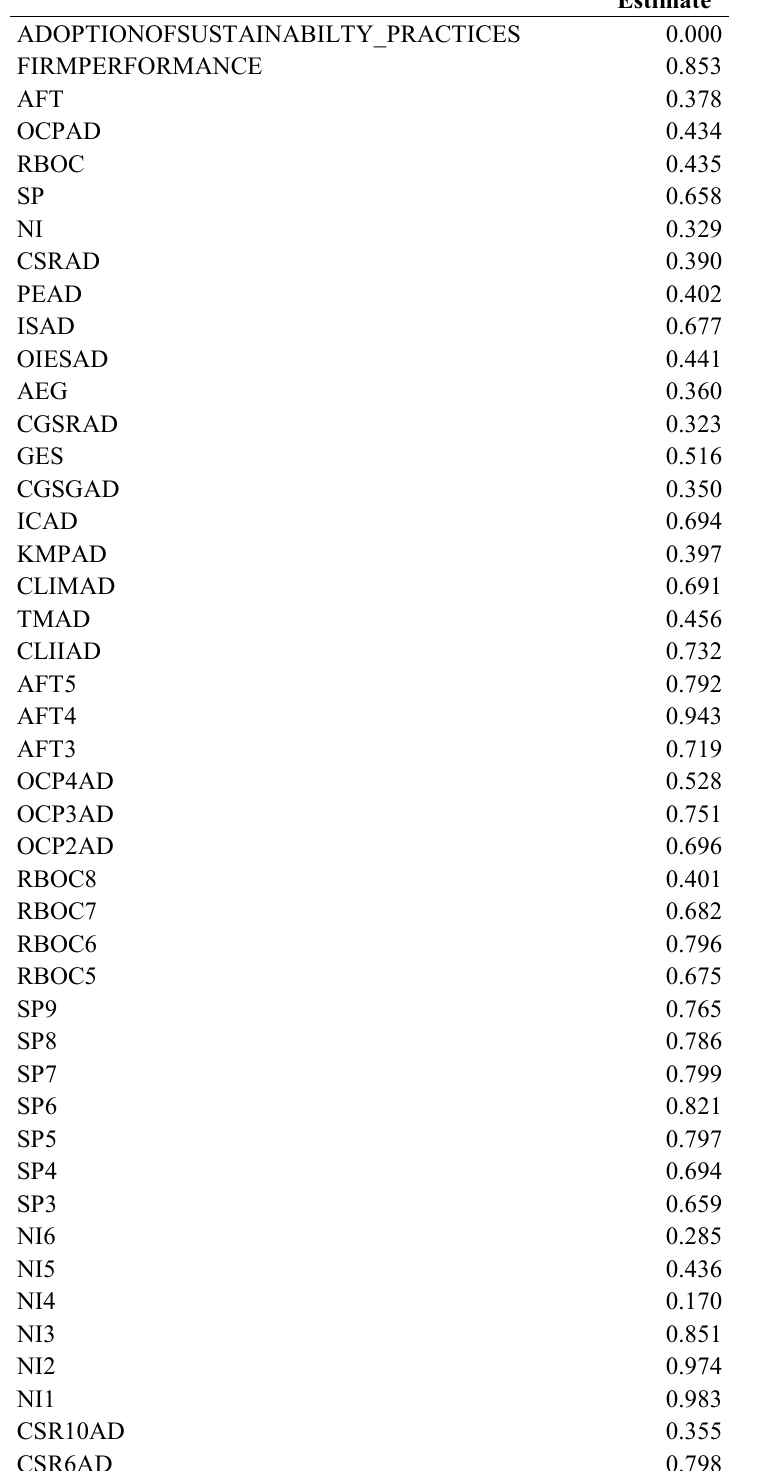
Table 3. Squared Multiple Correlations: Group Number 1 – Default Model (developed by the authors)